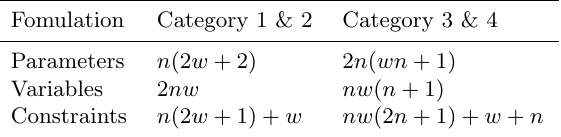
Table 1: Summary of the order of magnitude of the number of variables and constraints for the job scheduling models in § 3.1 and §